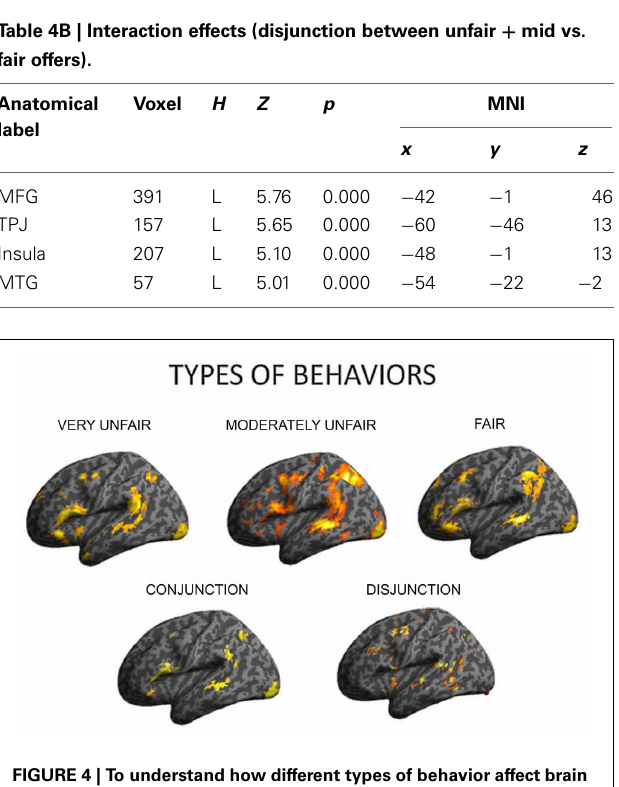
FIGURE 4 | To understand how different types of behavior affect brain responses, separate analyses were computed for the three levels of offer shown (very unfair, moderately fair, fair). Disjunction analyses clarified that insula and other regions differentiated selfish from altruistic behavior.